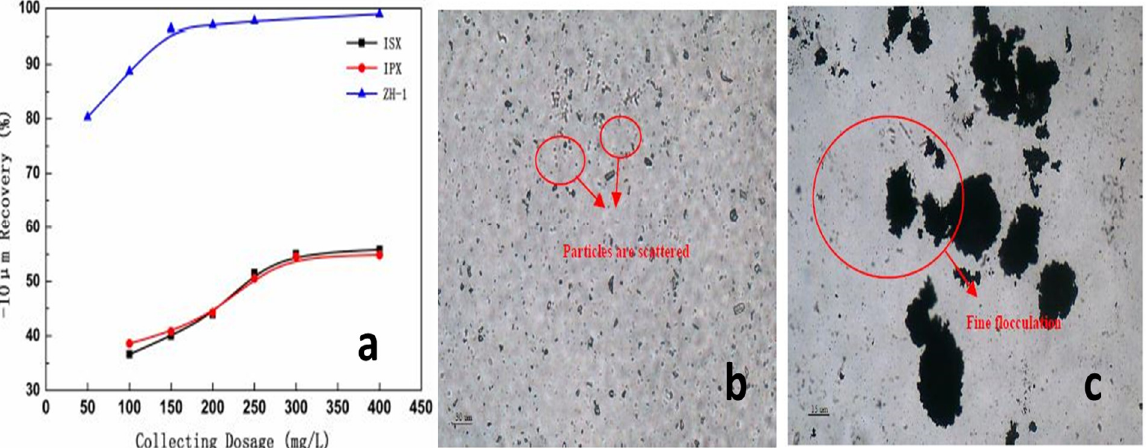
Figure 14. ( a ) Relationship between the collector dosage and the recovery of fine-grained malachite. Distribution of malachite particles under the microscope ( b ) before and ( c ) after adding ZH-1 [91].